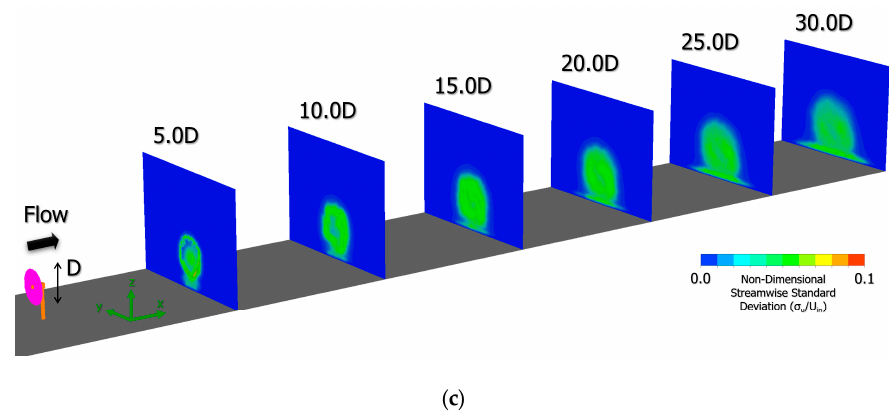
Figure 19. Spatial distribution of nondimensional streamwise standard deviation in the y–z plane (front view) at x = 5.0 D, 10.0 D, 15.0 D, 20.0 D, 25.0 D, and 30.0 D: ( a ) N = 4, ( b ) N = 10, and ( c ) uniform flow.